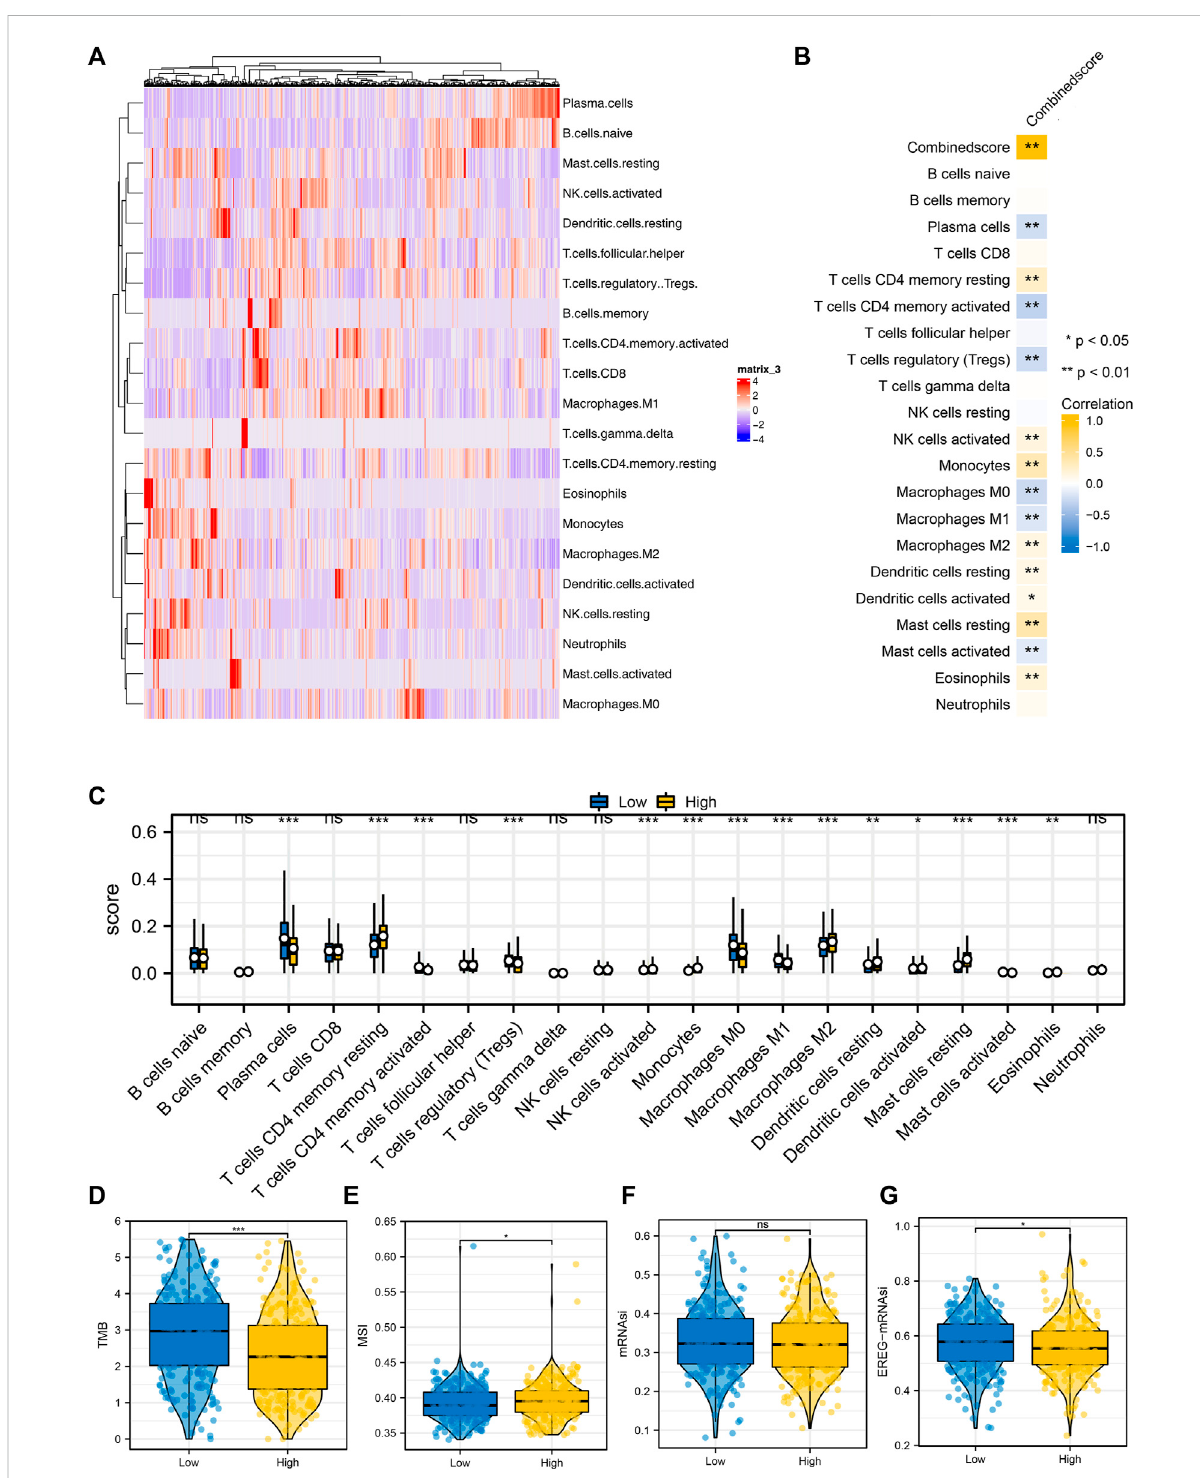
FIGURE 5 Immune in fi ltration analysis. Notes: (A) The CIBERSORT algorithm was utilized to quantify the immune in fi ltration in the LUAD tumor microenvironment; (B) Correlationoflogisticsscoreandquanti fi edimmunecells; (C) In fi ltrationlevelofquanti fi edimmunecellsinpatientswithhigh and low logistics score; (D – G) : Level of TMB, MSI, mRNAsi and EREG-mRNAsi in patients with high and low logistics